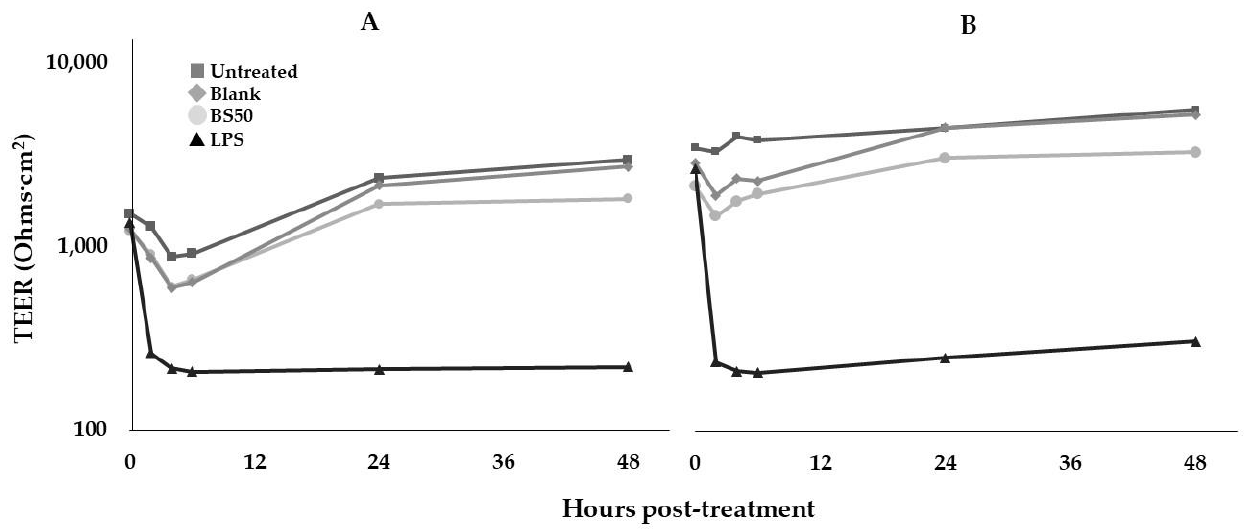
Figure 3. Effects of BS50 lysates on Caco-2 cell monolayer TEER in two separate trials ( A , B ). TEER was measured before treatment (0 h) and 2, 4, 6, 24, and 48 h after treatment. Square, untreated Caco-2 cells; diamond, “blank” lysate processing control; circle, BS50 lysate treatment; triangle, LPS treatment (TEER reduction control). Data are shown as two separate trials without replication within each trial ( n = 1). Values on the y -axis are plotted on a logarithmic scale.